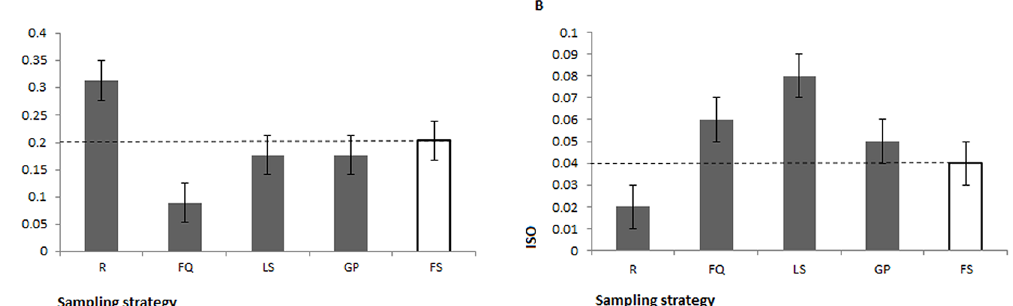
Fig 3. Average values and standard deviations of the S/N parameter (A) and isonymy (B) calculated with different sampling strategies in the present-day communities. S/N, relative number of surnames; ISO, isonymy. Sampling strategies: R, random; FQ, first quartile; LS, locally spread; GP, grandparents; FS, founder